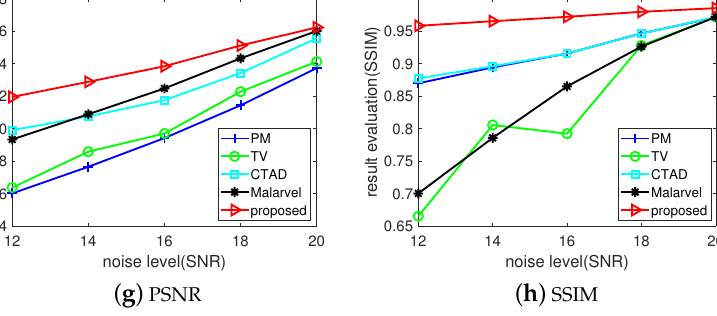
Figure 4. Results of test on artificial image